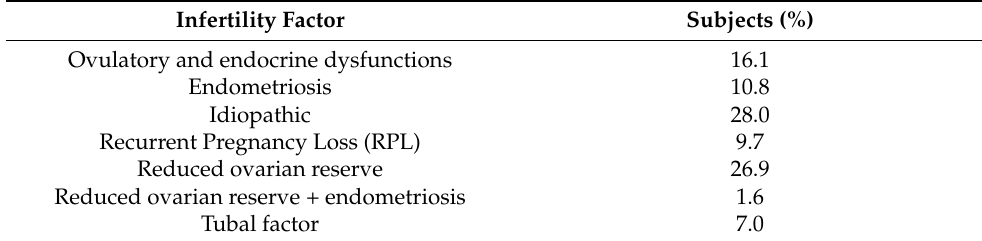
Table 4. Infertility factors identified in the female study